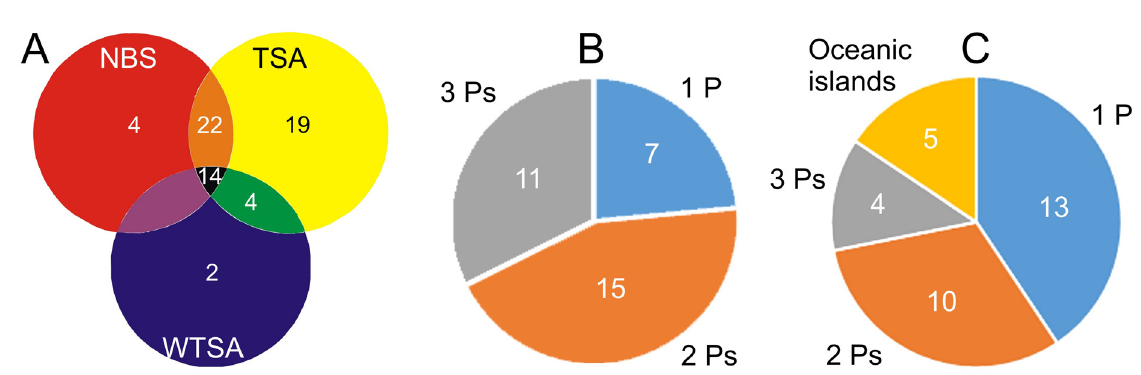
Fig. 82. Distribution of triphorids in Brazil according to the marine provinces of Spalding et al . (2007). A . Number of species in each province: NBS = North Brazil Shelf; TSA = Tropical Southwestern Atlantic; WTSA = Warm Temperate Southwestern Atlantic. B . Range of planctotrophic species in Brazil; ‘ n ’ Ps refer to species present in n provinces. C . Range of lecithotrophic species in Brazil (those exclusively living near oceanic islands were set